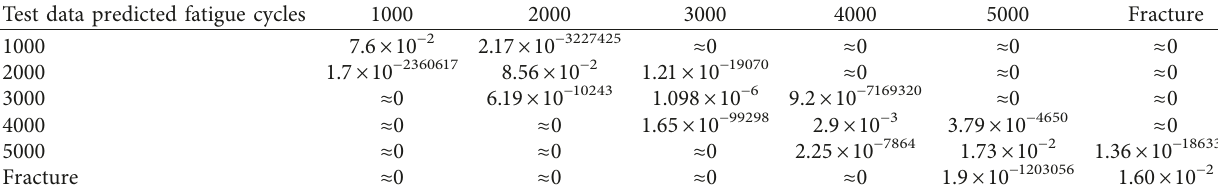
Table 4: Posterior probability values of test